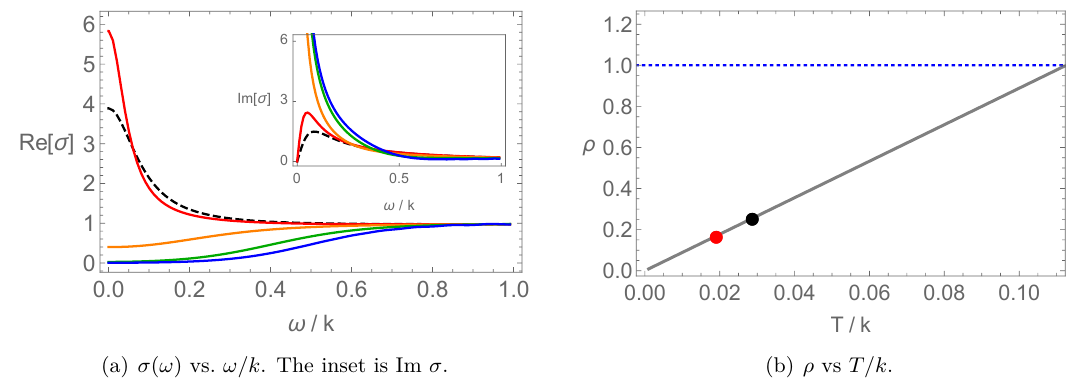
Figure 4 . The electic conductivity at µ/k = 0 . Left: σ ( ω ) of the Gubser-Rocha model at T/T c = 1 . 5 , 1 , 0 . 93 , 0 . 75 , 0 . 41 (dashed, red, orange, green, blue). Right: the DC resistivity ρ ( 1 /σ ( ω = 0) ) of two holographic models: the Gubser Rocha model (solid gray) (3.10), the linear axion model (dotted blue) (3.11). The black (red) dot corresponds to the DC limit of the black (red) line